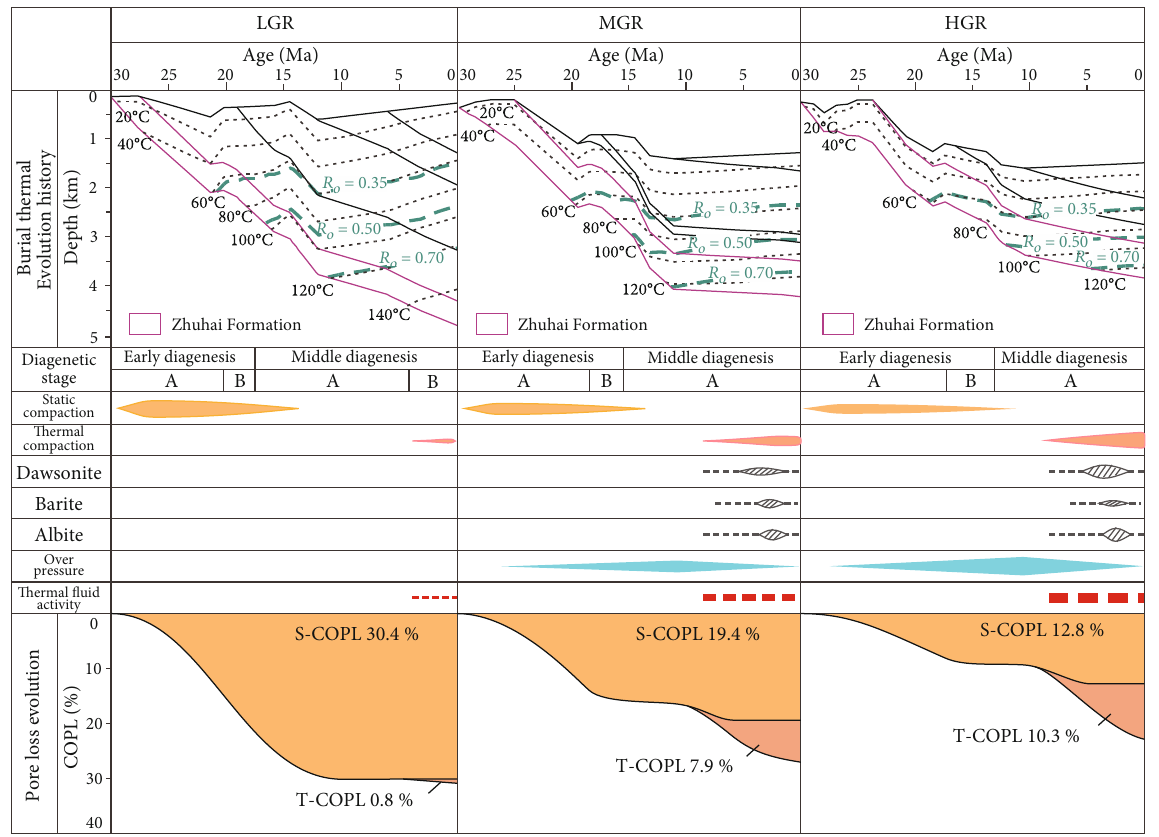
Figure 11: Burial-diagenetic-COPL model in di ff erent geothermal gradient